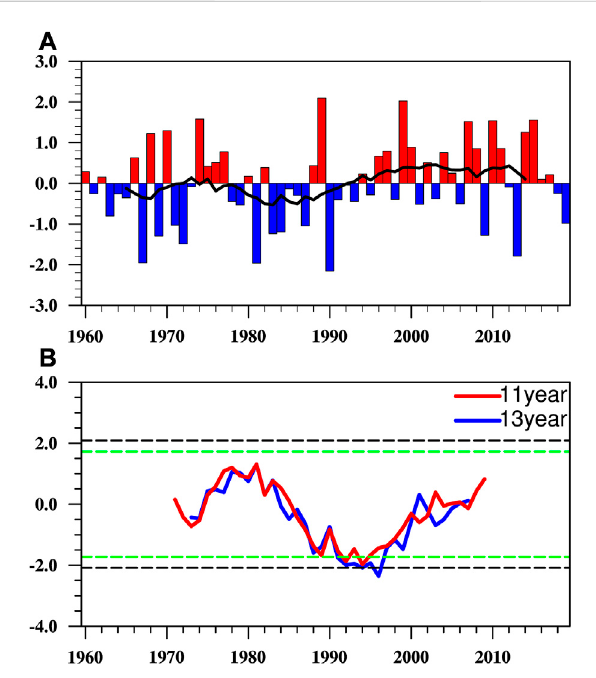
FIGURE 4 (A) The normalized time series of the ZWI (bar) and the corresponding 11-year running mean (line) during 1960 − 2019. (B) The moving t -test of the ZWI during 1960 − 2019, with window lengths of 11-year (red line) and 13-year (blue line). The green (black) horizontal dashed lines indicate the 90% (95%) con fi dence level.